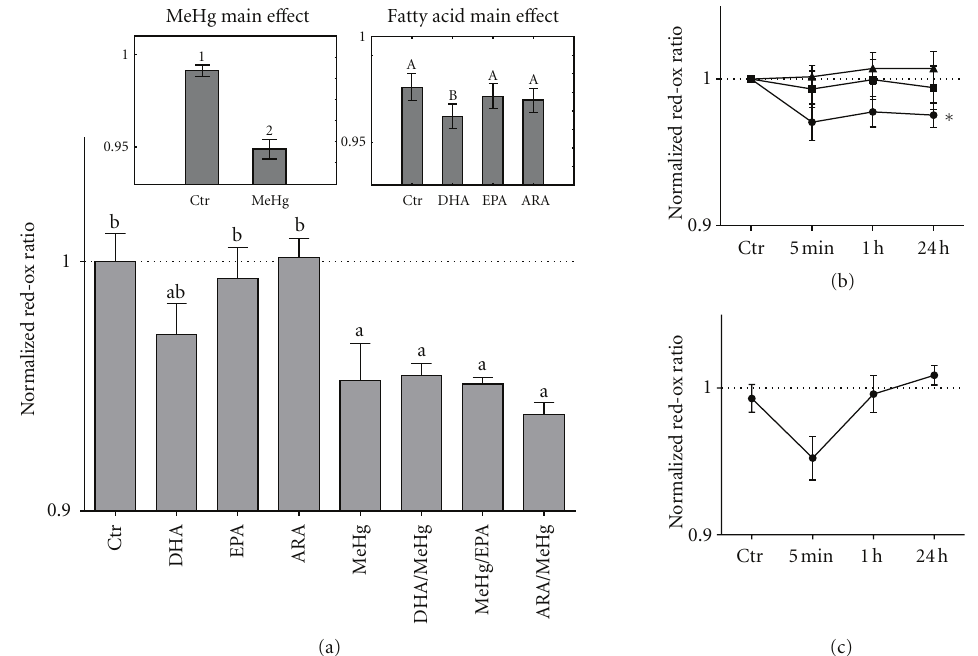
Figure 7: Fatty acid and MeHg e ff ect on red/ox balance in HEK293 cells. (a) Relative fluorescent value of the cells 5 minutes after exposure to the di ff erent compounds. Data are treated by two-way ANOVA and main e ff ects analyzed by post hoc Fischer’s test. Significant di ff erences ( P < 0 . 05) due to MeHg exposure (MeHg main e ff ect) are represented using lettering. Significant di ff erences ( P < 0 . 05) due to fatty acid treatment (fatty acid main e ff ect) are represented using large letters. Interaction e ff ects were analyzed using post hoc Dunnett’s test where significant di ff erences ( P < 0 . 05) compared to control are visualized by small letter a, while significant di ff erences ( P < 0 . 05) compared to MeHg are visualized using small letter b. Dotted line represents normalized control values. (b) Relative fluorescent ratio of fatty acids compared to control over time. Circles represent DHA, squares represent EPA, and triangles represent ARA. The dotted line represents normalized control values. Data are treated with one-way ANOVA followed by a post hoc Dunnett’s test; lines significantly di ff erent ( P < 0 . 05) from control are marked with ∗ . (c) Relative fluorescent ratio of MeHg compared to control over time. Black dots represent MeHg, while the dotted line represents normalized control values. Error margins are signified using standard